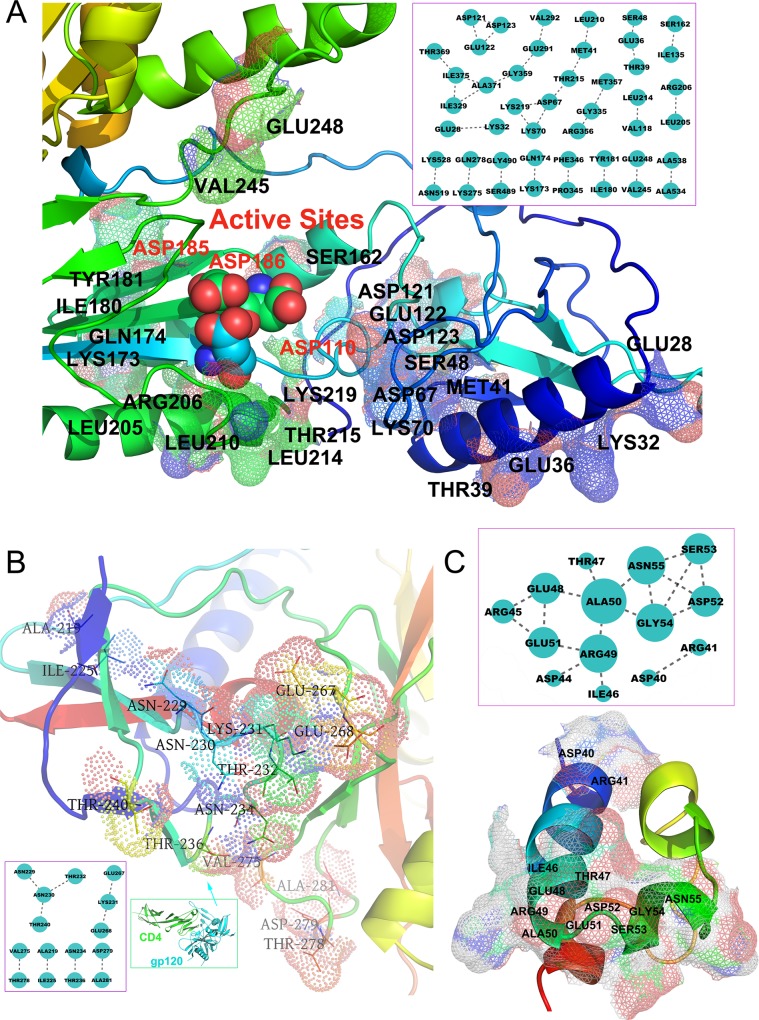
HIV protein sectors underlying conserved, independently varying biological activities.(A) The coevolving residues in RT enzyme were located near the three catalytically essential amino acid residues (Asp110, Asp185, and Asp186) for polymerase catalysis. (B) For gp120, the coevolving residues were located near the protein-protein interface between gp120 and CD40, especially for Glu267, Glu268, Thr278 and Asp279. (C) For VPU protein, 6 out of 12 coevolving residues in the protein sector are charged amino acids. The figures were generated using PyMol (http://www.pymol.Org). The protein structures were colored with a default spectrum of rainbow colors in Pymol. The mesh surfaces of the coevolving residues were added while the different colors correspond to different amino acid residues.